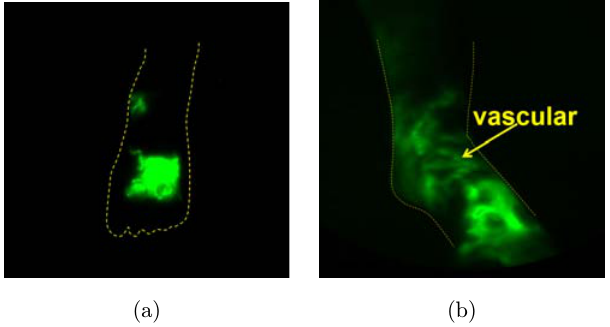
Fig. 7. NIRFLI image of subject 2's anterior medial left foot before (a) and after (b) PCT treatment in subject 2. Extravascular/ di®use and vascular/linear (arrow) dye/lymph are visible.